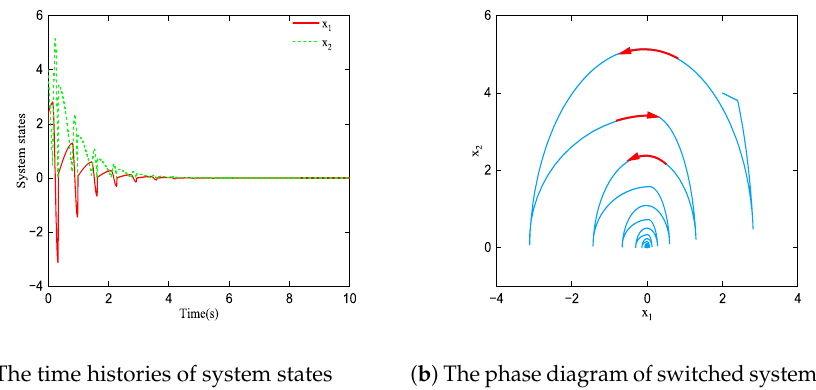
Figure 9. The switched system (15) is asymptotically stable under the switching rule ( 1 → 3 → 2 → 1 ) .